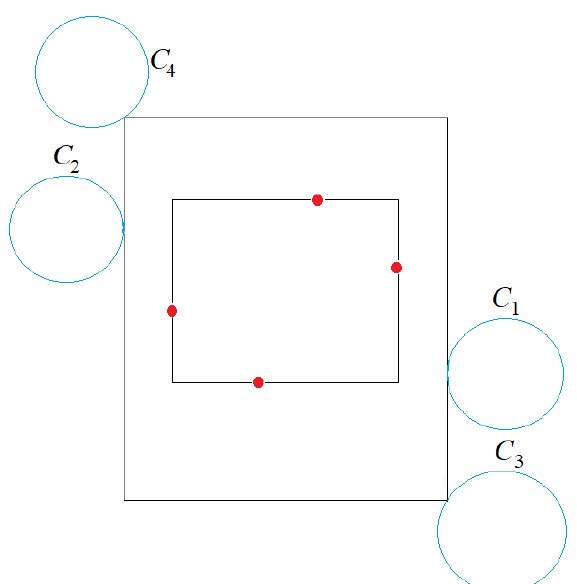
Figure 16. Case 2.3: Two circles C 1 , C 2 pin the CSR on the east and west edges. The other two edges are uniquely